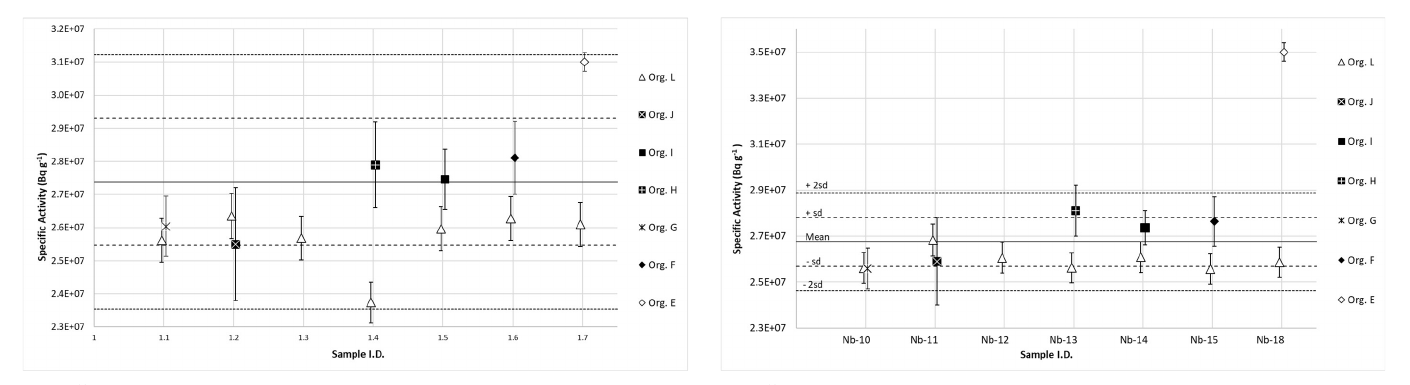
Fig. 1 93m Nb Specific activity measurements obtained for B.1, 1mg strip with 0.3ppm Ta Fig. 2 93m Nb Specific activity measurements obtained for B.2,1mg strip with 4 ppm Ta